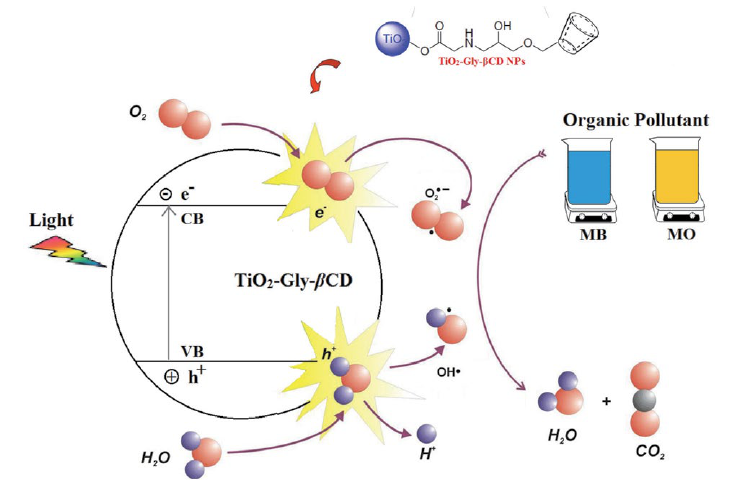
Fig. 9. Mechanism of photocatalytic degradation of dyes using TiO